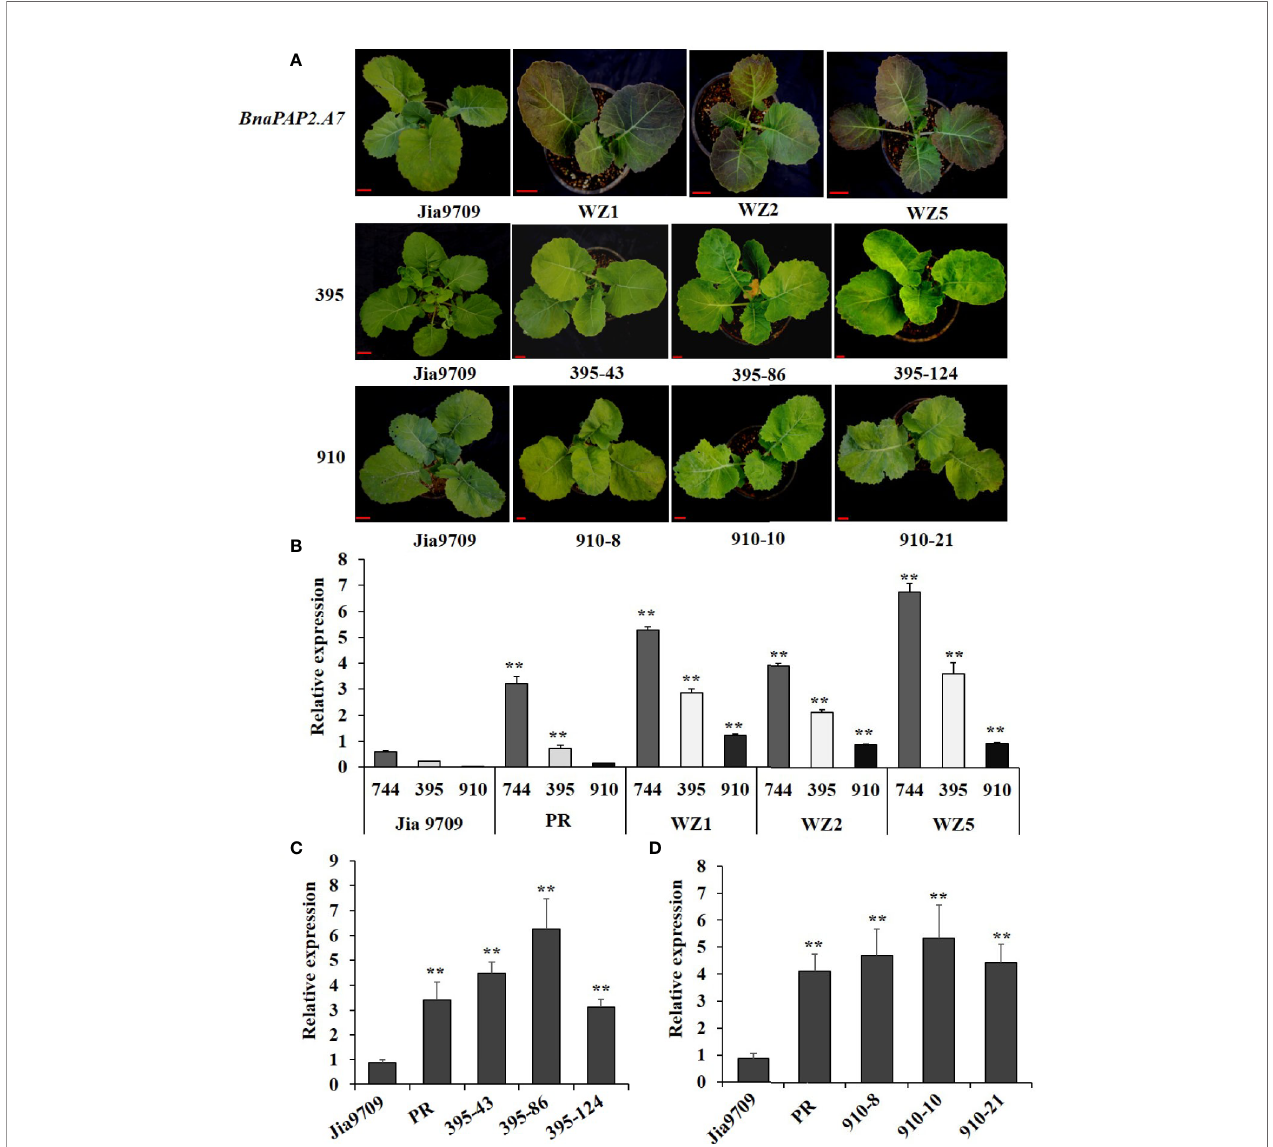
FIGURE 7 | Transgenic analysis of full-length BnPAP2.A7 and three isoforms in green rapeseed. (A) Phenotypes of transgenic lines at the seedling stage containing full-length PR BnaPAP2. A7 , 395, and 910 isoform driven by the same 1.99kb promoter of BnaPAP2. A7 . Scale bar: 1 cm. (B) qRT-PCR analysis of three isoforms in transgenic plants with full-length BnaPAP2. A7 . (C , D) qRT-PCR analysis of 395 (C) and 910 (D) isoforms in respective transgenic plants. **P < 0.01, one-way ANOVA test. Error bars represent the SD of three